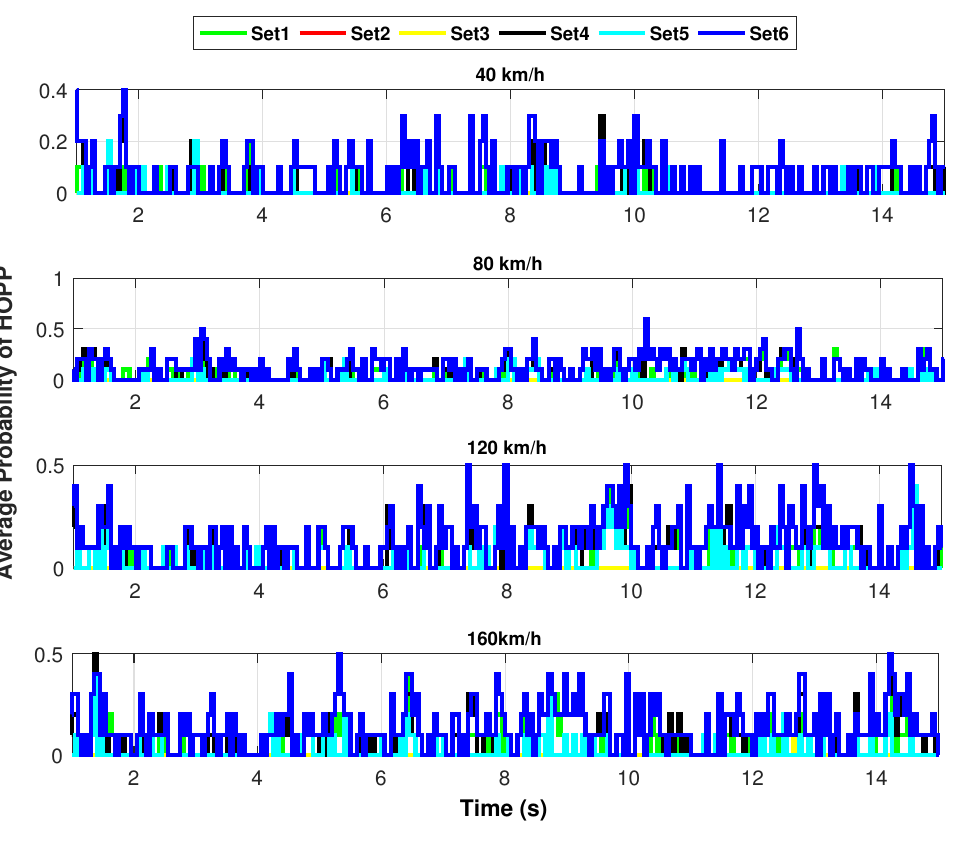
Figure 4. Average probability of HOPP vs. time.